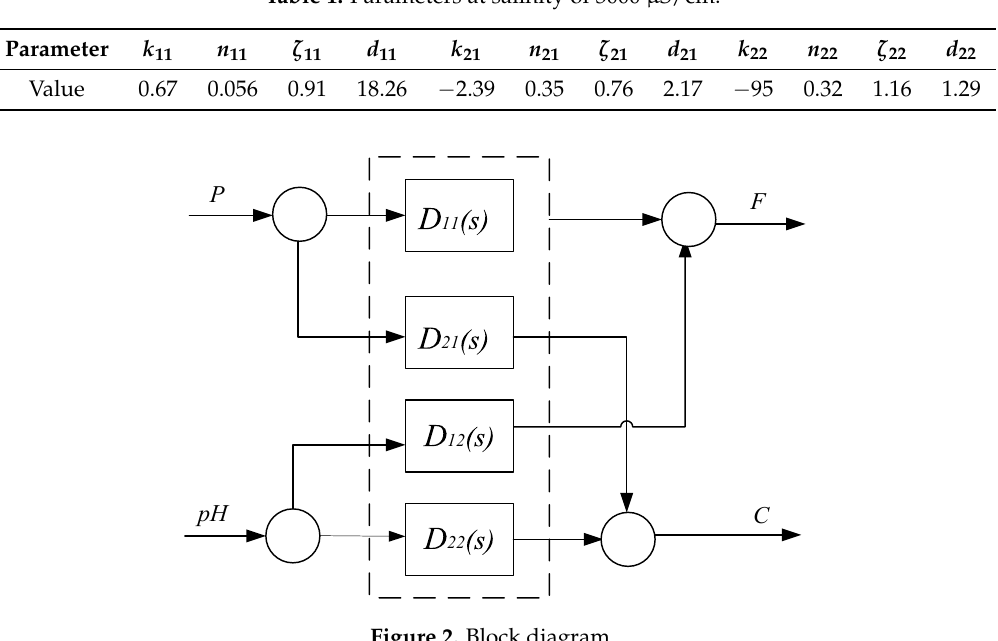
Fig. 2. Block diagram. Figure 2. Block